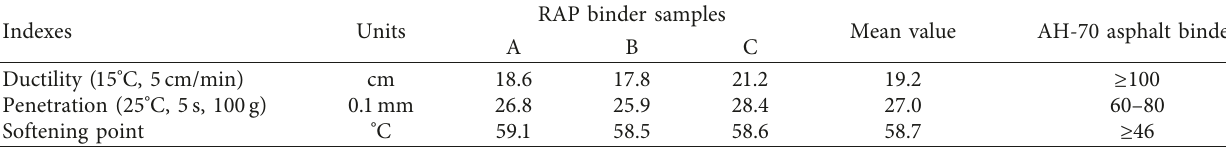
Table 1: Properties of RAP binder.